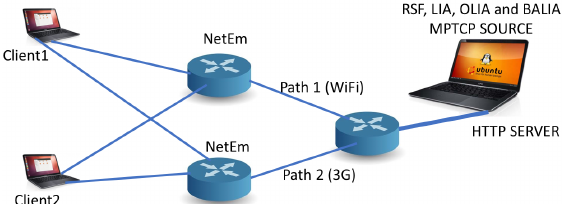
Figure 2. Experimental setup: Ethernet links emulate the characteristics of WiFi and 3G paths.